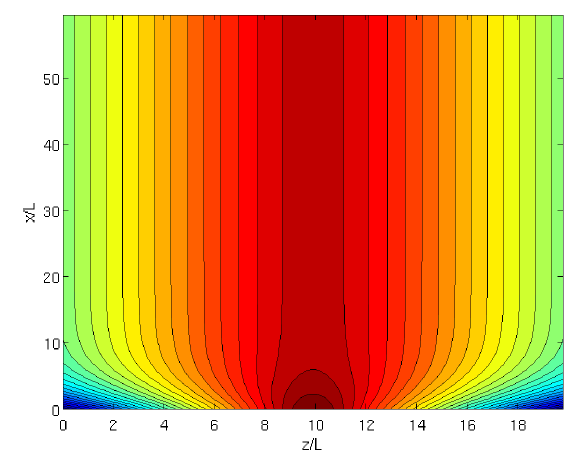
Fig. 1. Initial Helmet Streamer equilibrium. Note that the vertical and horizontal axis are not on the same scale, the vertical axis is compressed. field. The flow is present only outside of the two separatri- ces, where the field lines are open and is zero inside, where the field lines are closed. At the bottom boundary ( x = 0), the field lines are tied